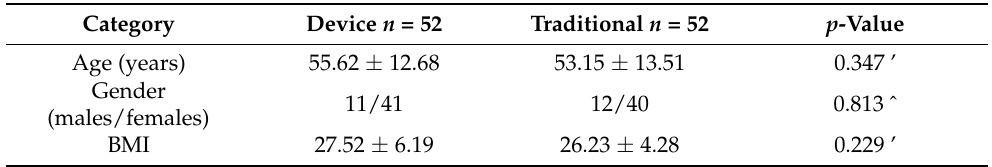
Table 1. Descriptive statistics of the population. Mann–Whitney = ’, Chi square = ˆ. Abbreviation: BMI: Body Mass